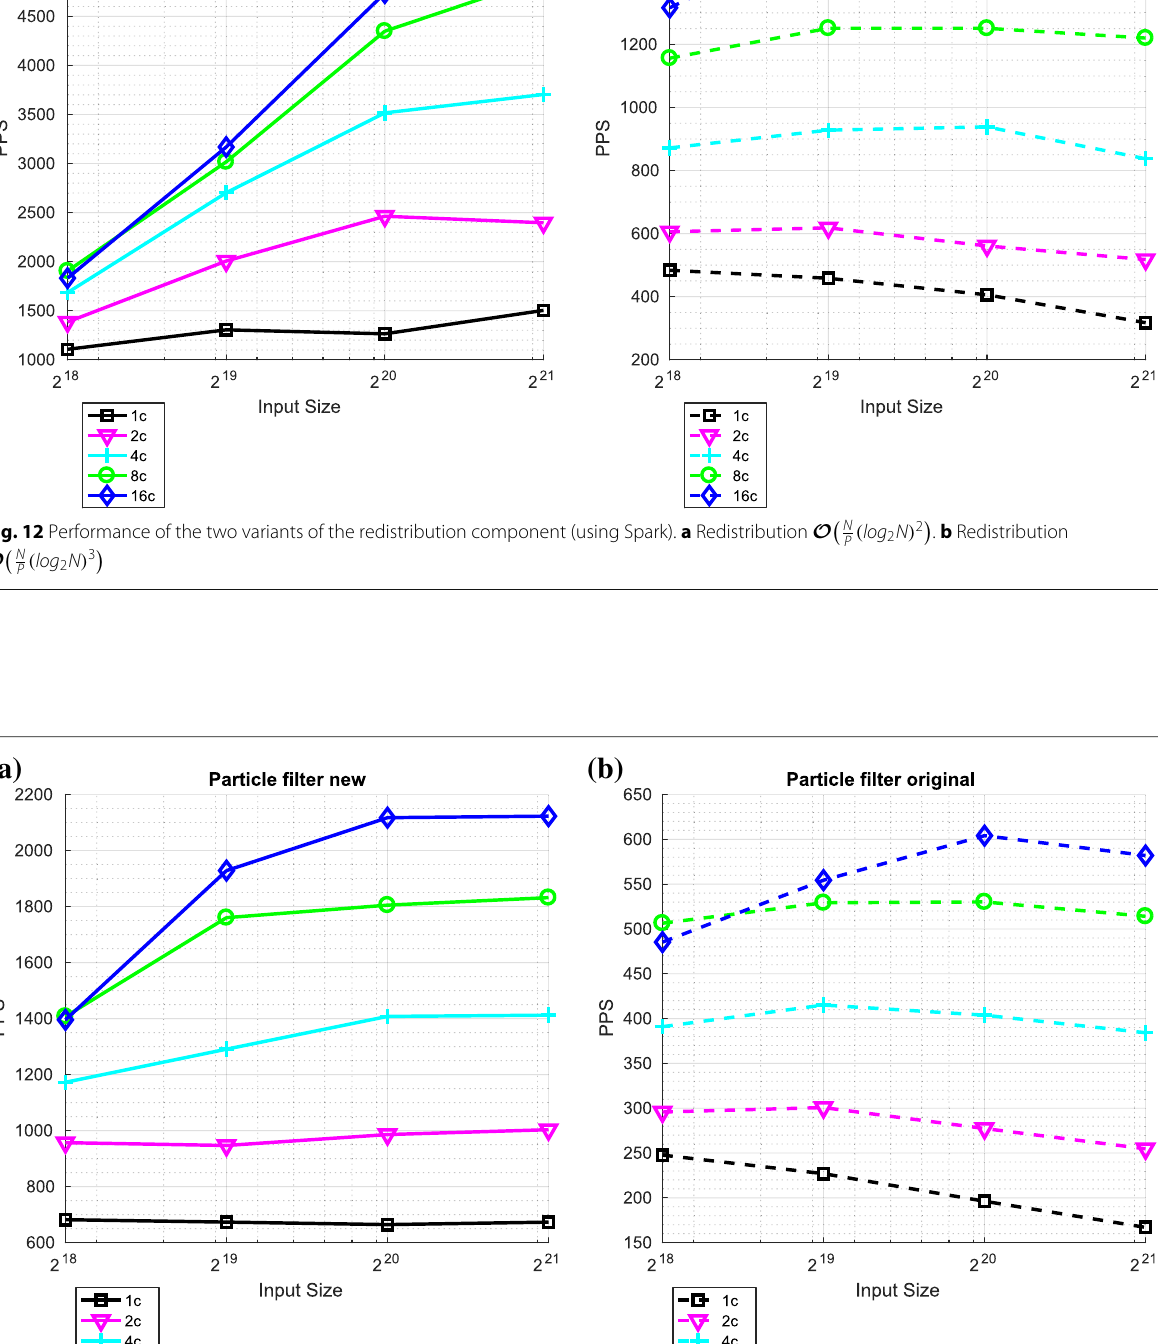
(cid:2) (cid:3) N ( log ) 2 . b Particle 2 N P